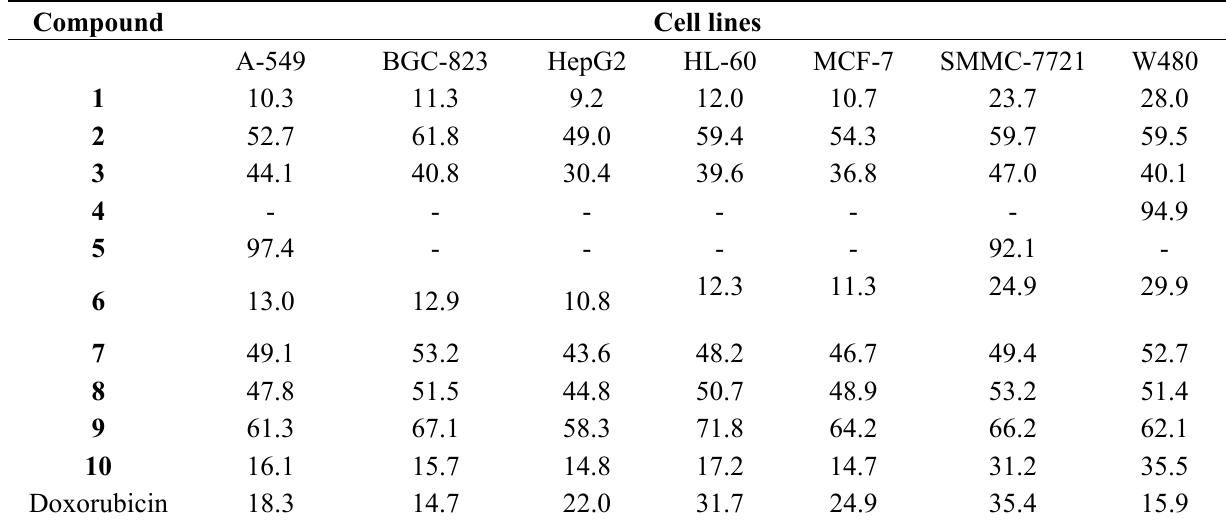
Table 2. Cytotoxicity of compounds 1 – 10 against seven human tumor cell lines (IC